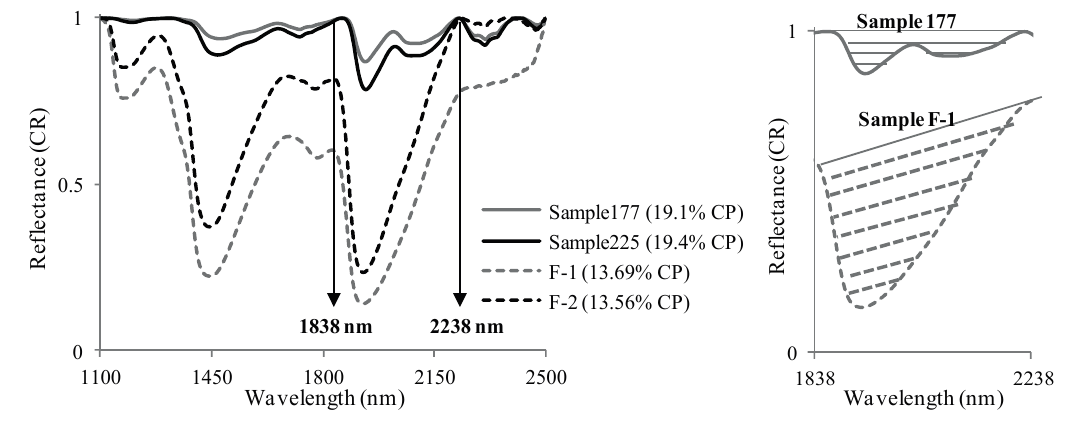
Figure 8. Continuum removal (CR) of four samples to demonstrate the difference in absorption area between the dried and fresh samples.